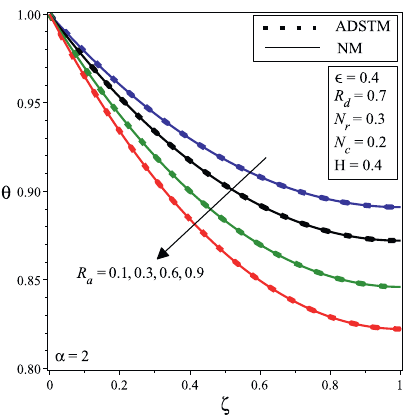
Fig. 8: Effect of Radiation–conduction parameter, R a and compar- ison between the ADSTM with the numerical solution for classical order α =